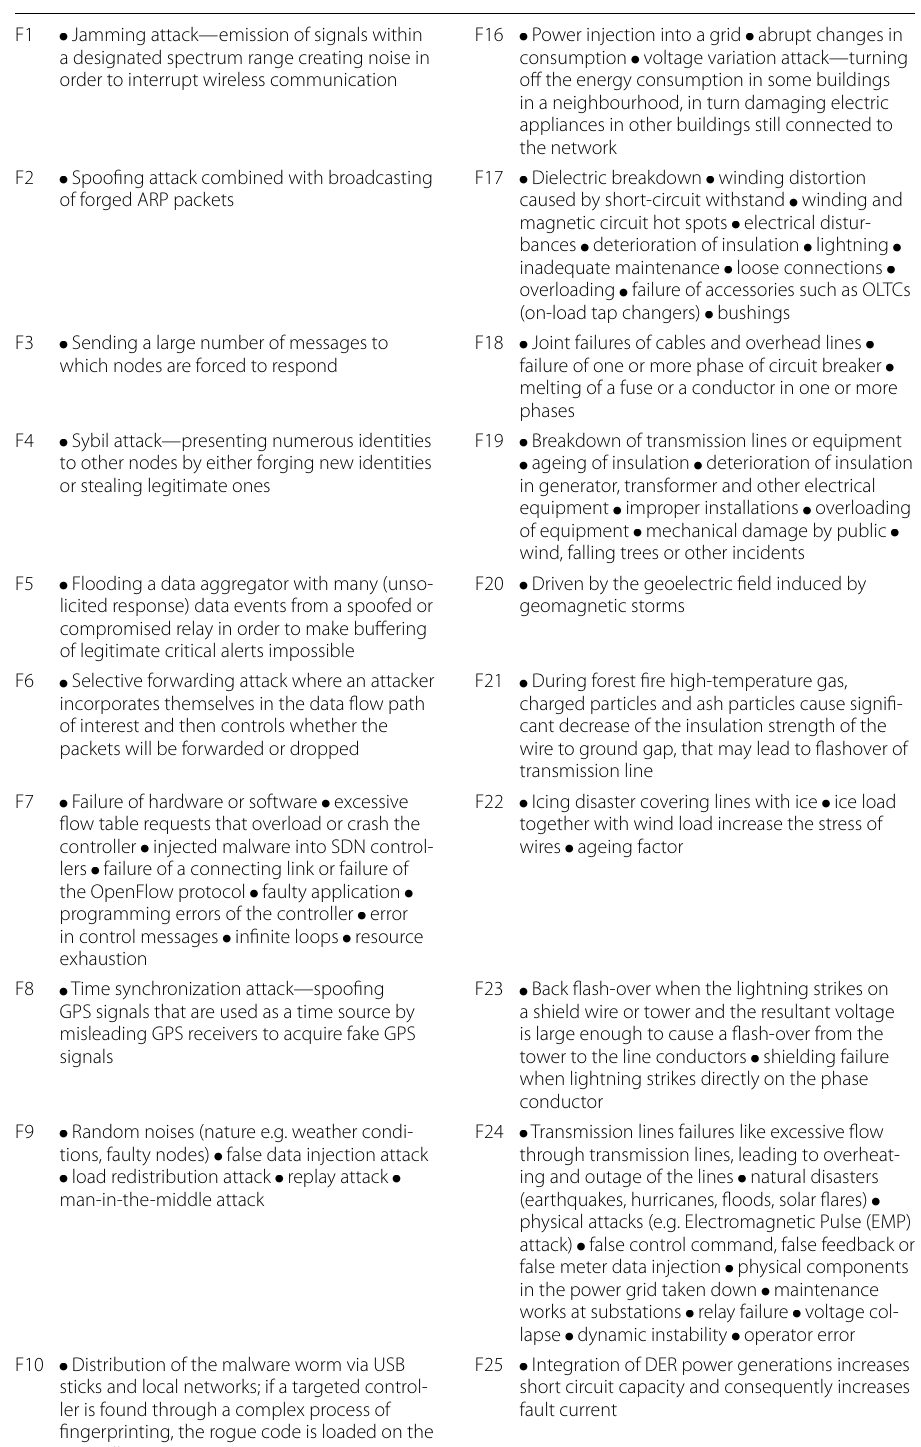
Table 7 RQ4 (Causes of found faults and failures) F/F Causes F/F